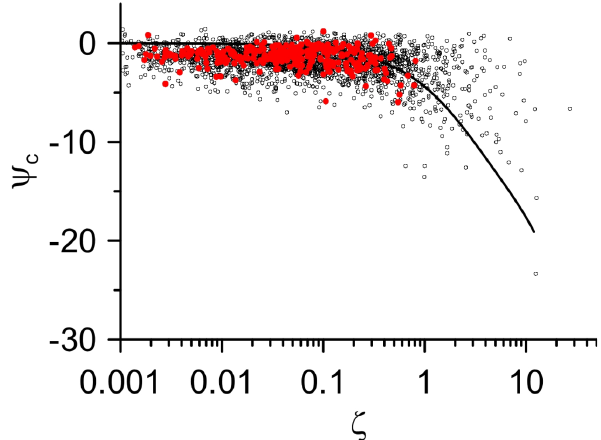
Fig. 4. Relationship for the trace gas stability correction function ψ c between the dependence of integrated profile at 4.4m ( z F ) based on measurements at 2.5m ( z − ) and 16.2m ( z + ) on stability ς . The measured values (circles) and the nominal relationships according to Holtslag and de Bruin (1988) (solid line) are indicated. The remaining data after the quality assurance procedure stated in the text are red.